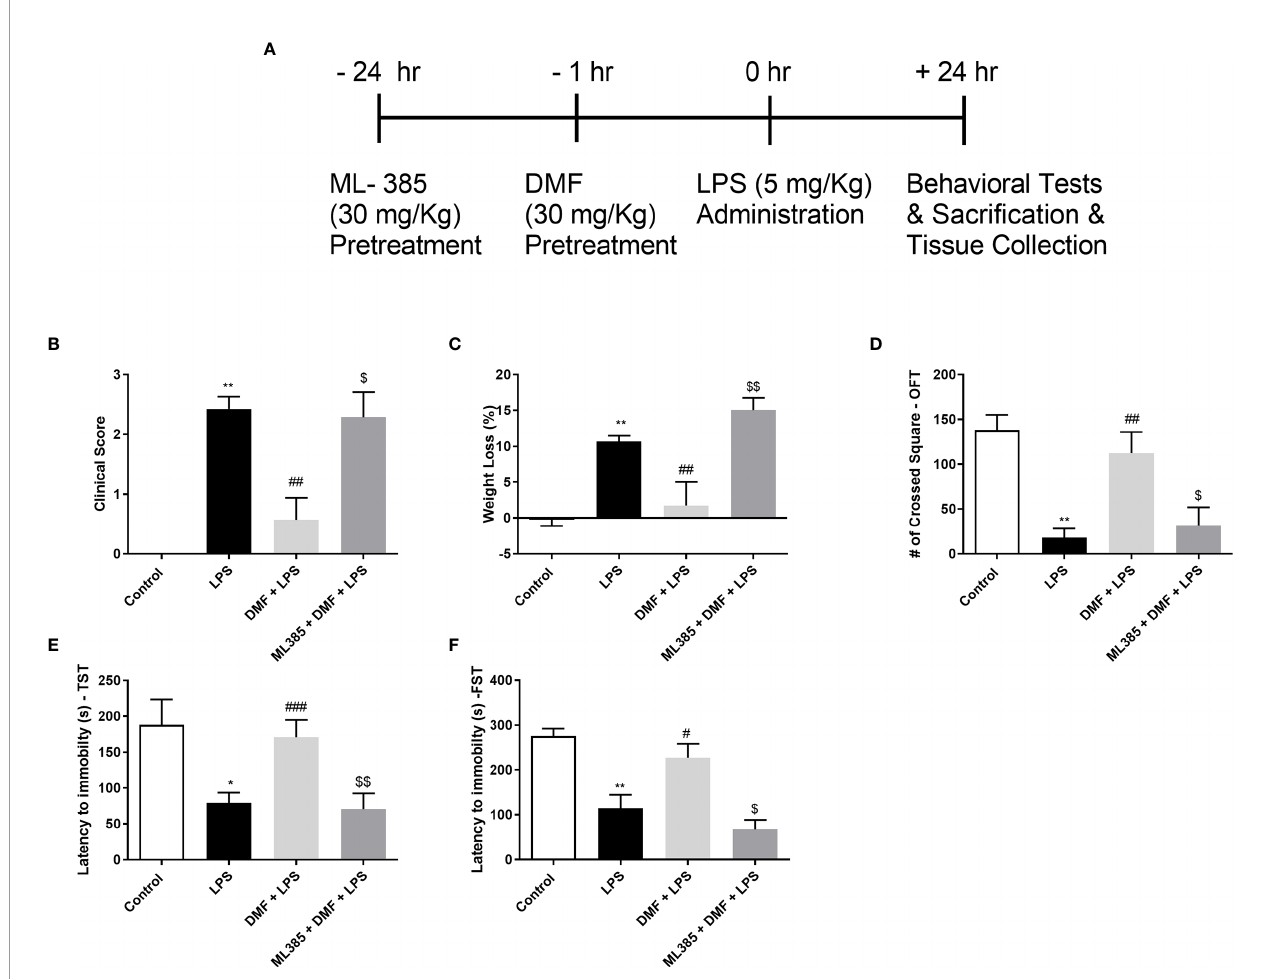
FIGURE 7 | DMF alleviated sickness behaviors in LPS-challenged mice. DMF administration to LPS-challenged mice prevented weight loss and improved clinical and behavioral scores. (A) A schematic representation of the study design (B) Clinical evaluation of mice (n=7/group) and (C) Changes in the weight of mice. Assessment of sickness behaviors was conducted with OFT (D) , TST (E), and FST (F). Data are presented as mean ± S.E.M, n = 5. *p < 0,05, **p < 0.01 compared to control, # p < 0.05, ## p < 0.01, ### p < 0,001 compared to LPS-challenged mice, $ p < 0,05, $$ p < 0,01 compared to DMF-administered